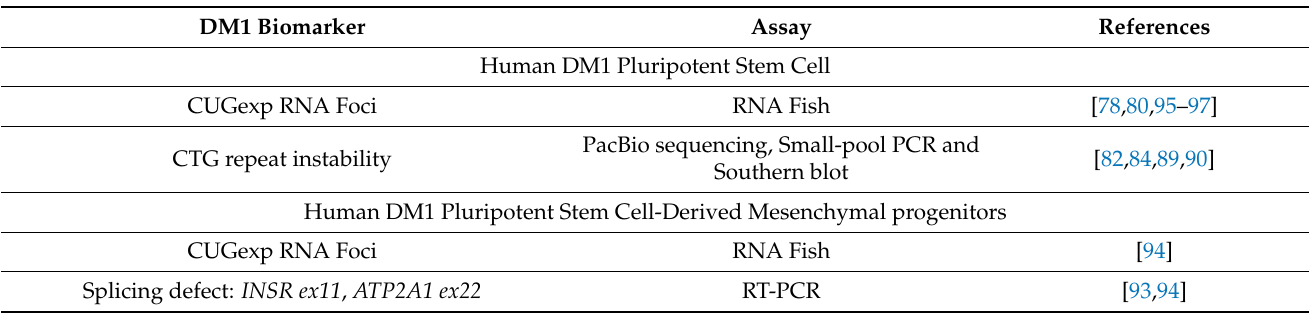
Summary of the different pathological phenotypes identified in DM1 hPSC and their